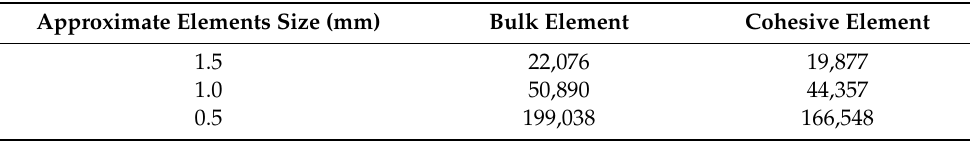
Table 2. The time consumption of the models with element size of 1.0 mm and 0.5 mm are 2.5 and 11.6 times that of the model with 1.5 mm element size, respectively. Table 2. The bulk and cohesive elements number of the model with di ff erent mesh Table 1. Aggregate gradation and particle number.